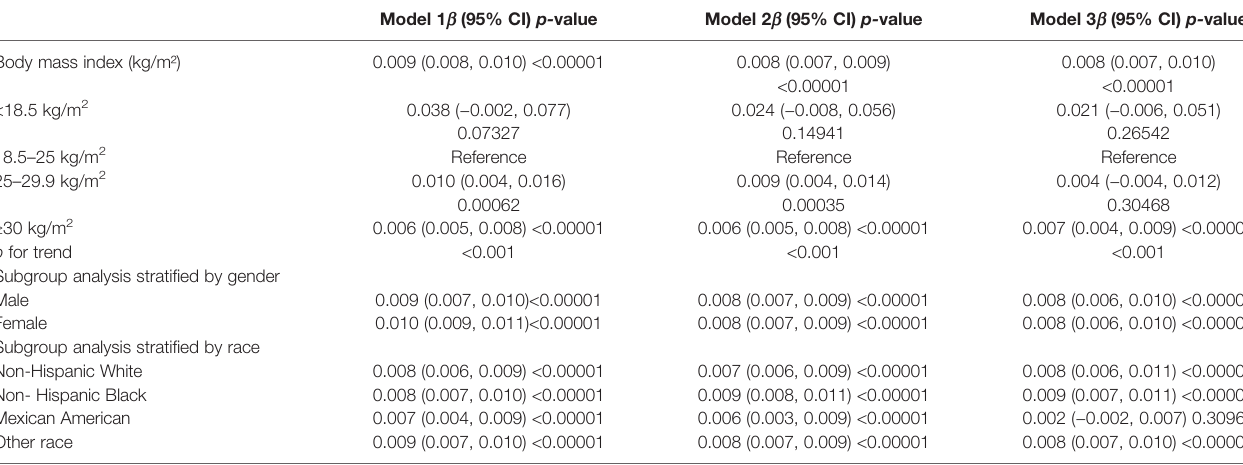
TABLE 2 | Association between body mass index (kg/m²) and femoral neck bone Mineral density (g/cm 2 ).